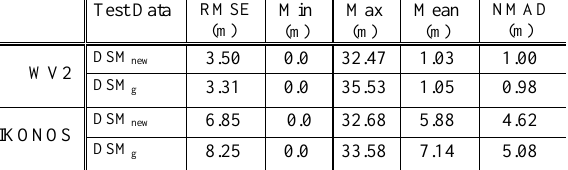
Table 1: Statistical evaluation for Munich study area in WV2 and IKONOS dataset. The filled DSM and the given DSM are compared to the LiDAR DEM as reference dataset.